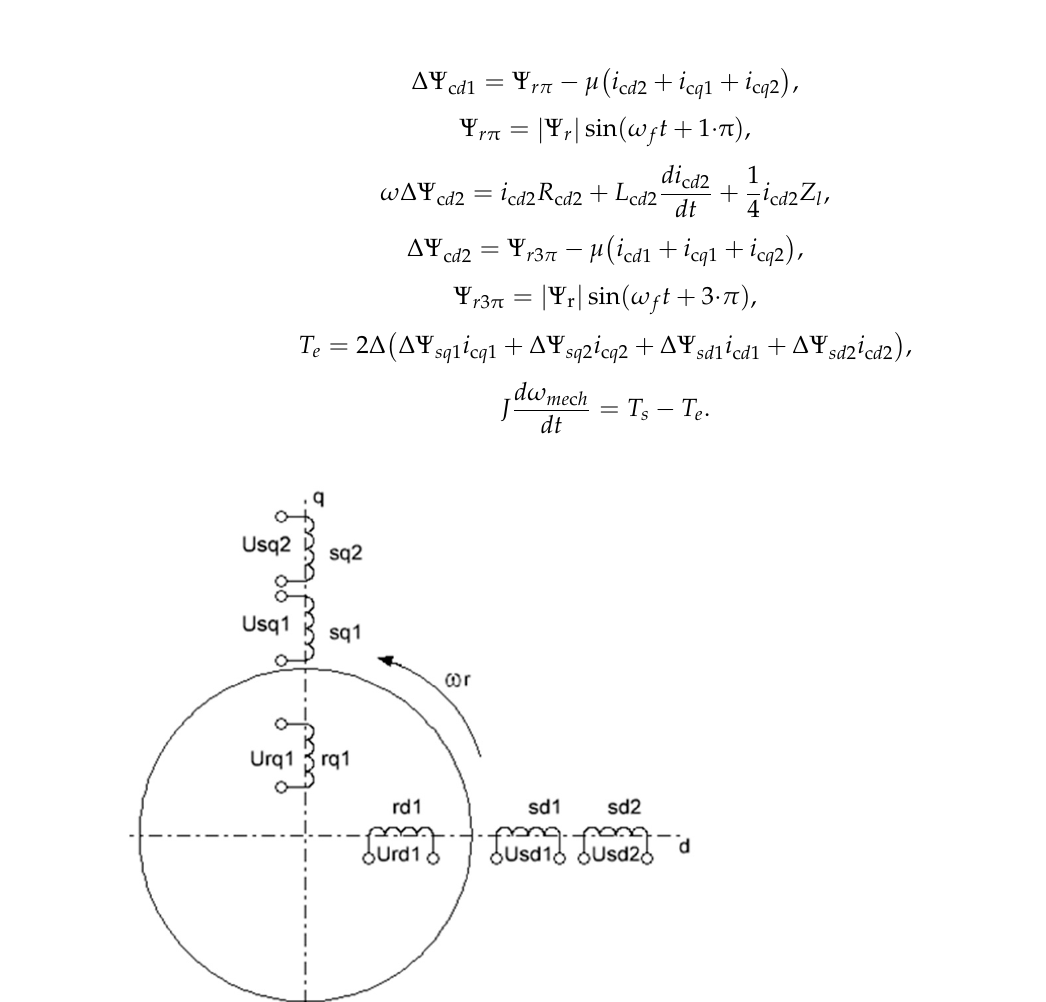
Table 1. Parameters of coefficients for mathematical description.